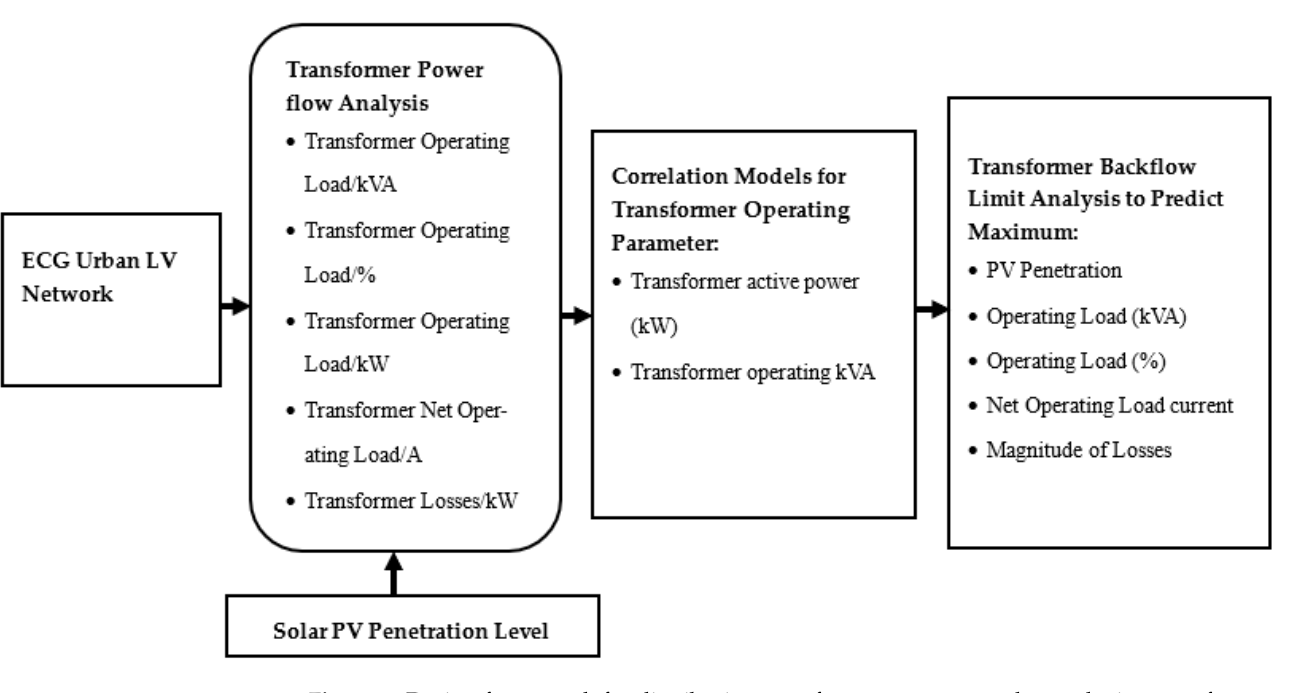
Figure 2. Design framework for distribution transformer assessment due to the impact of reverse power flow in a PV solar-photovoltaic-integrated low-voltage network .